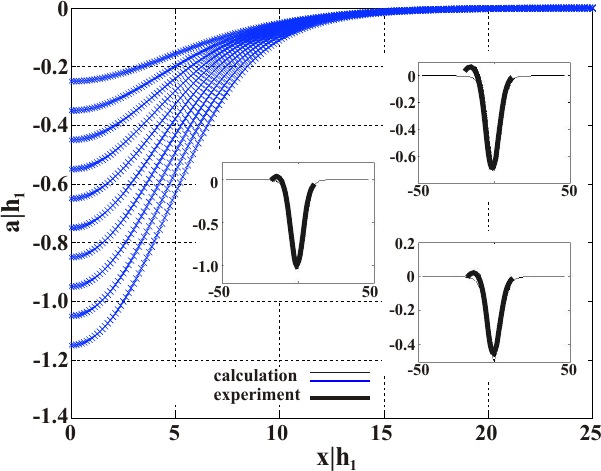
Fig. 11. Profiles of solitary waves of depression cal- culated via full Euler equations for ρ 2 /ρ 1 = 1 . 022, h 2 /h 1 = 6 . 15. Curves correspond to the values of a/h 1 = 0 . 25 , 0 . 35 , 0 . 45 , 0 . 55 , 0 . 65 , 0 . 75 , 0 . 85 , 0 . 96 , 1 . 05 , 1 . 15 (from upper to lower curve respectively). Panels inside illustrate comparison of shapes of induced solitons with the fully nonlinear theory.